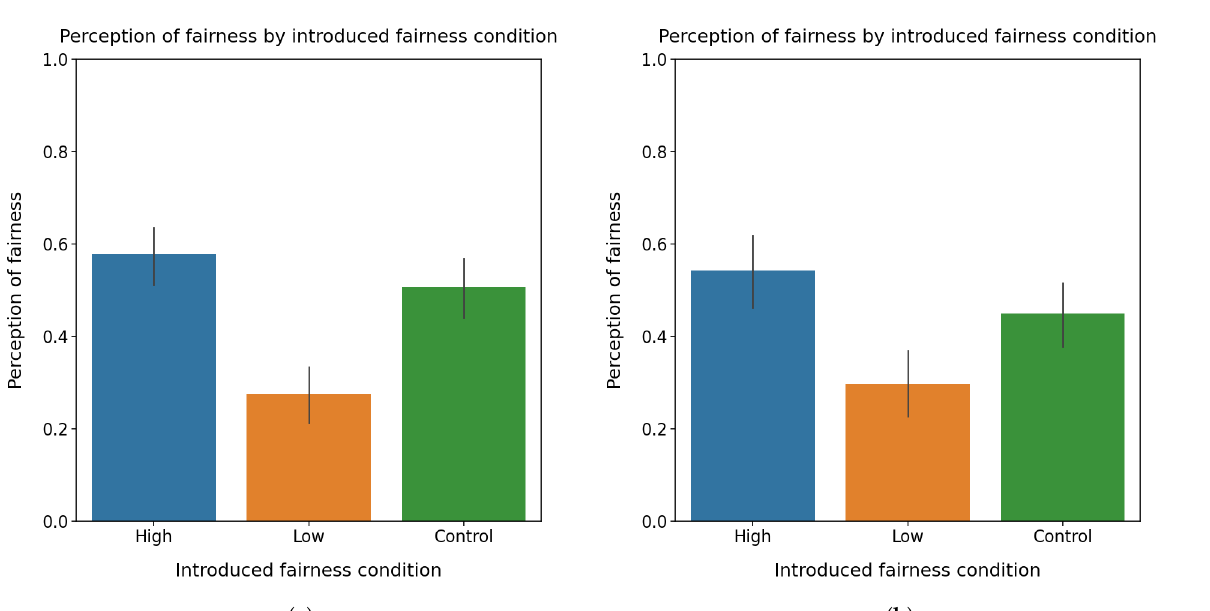
Figure 12. Perception of fairness over introduced fairness in two scenarios. ( a ) Health insurance decision-making. ( b ) Medical treatment